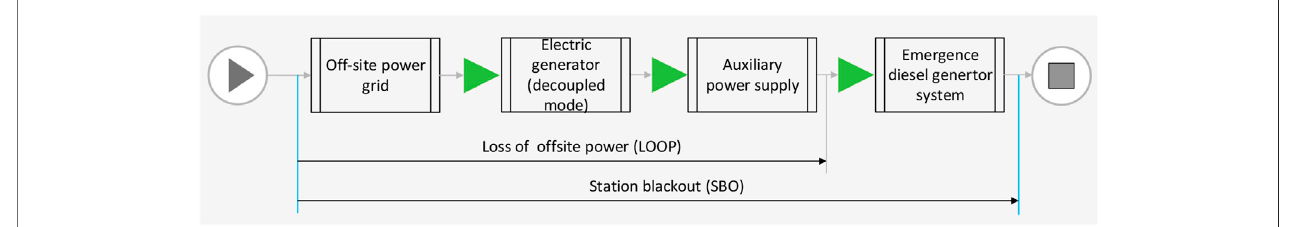
FIGURE 1 | Demand order of Power supply of one Chinese 1000MWe